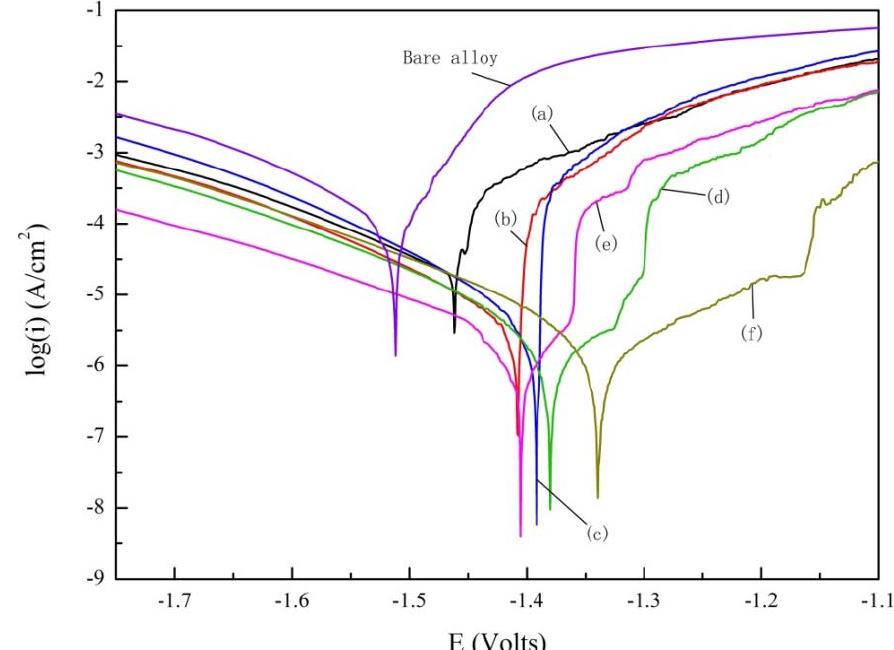
Figure 6. The typical potentiodynamic polarization curves obtained for the substrate and MAO coatings at pretreatment of different concentration of Nd(NO 3 ) 3 in 3.5 wt % NaCl solution: (a) 350–0, (b)